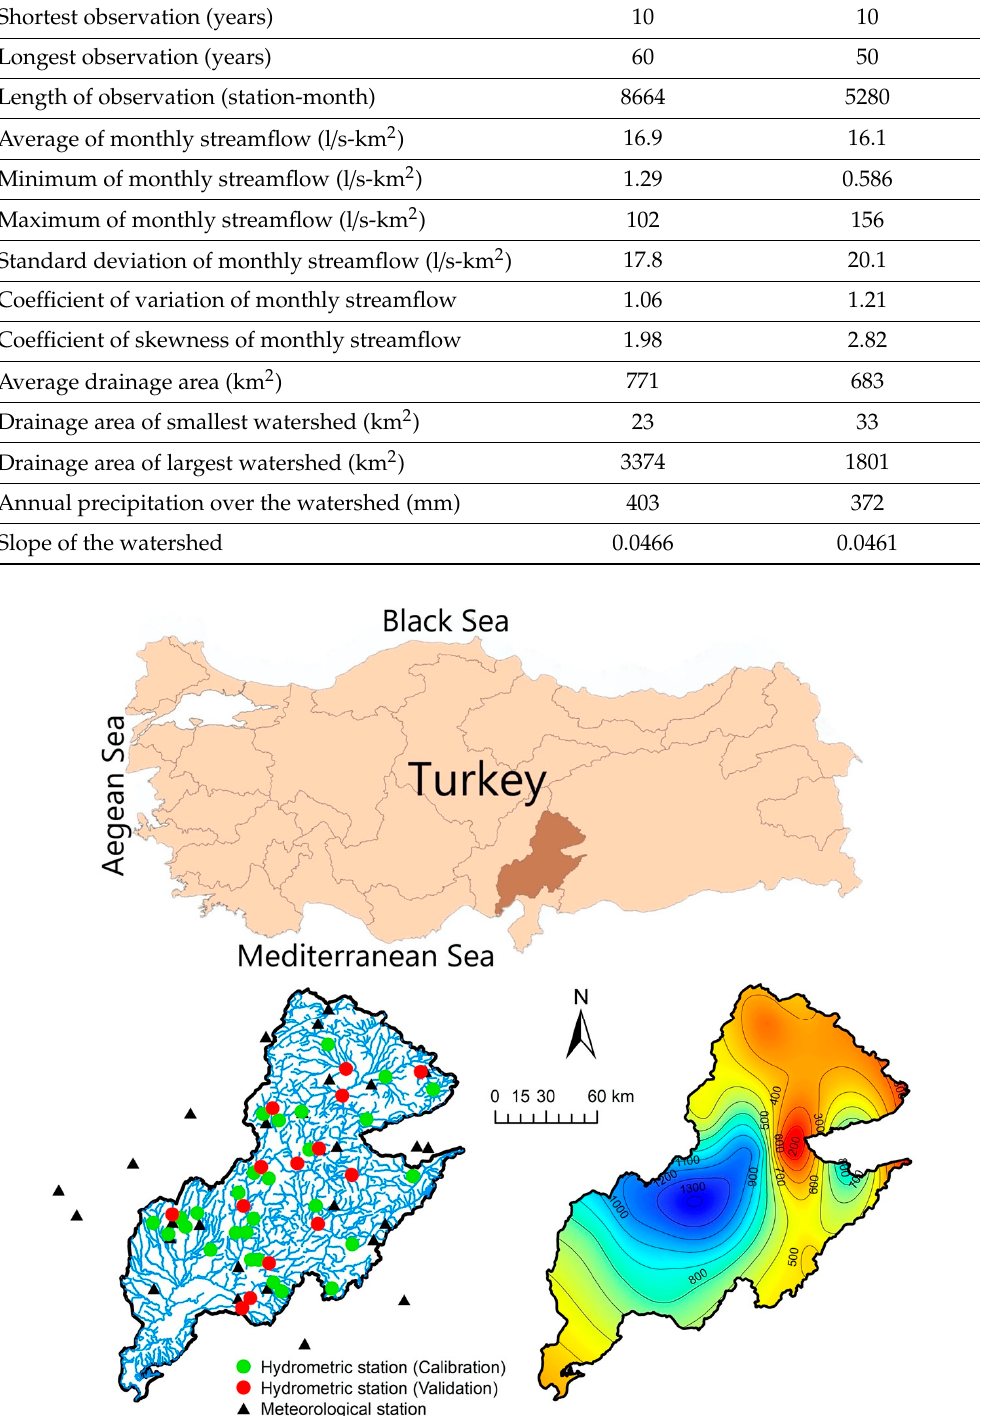
River Basin in Figure 2. Water courses, hydrometric and meteorological stations and an isohyet map of the Ceyhan River Basin in Turkey.